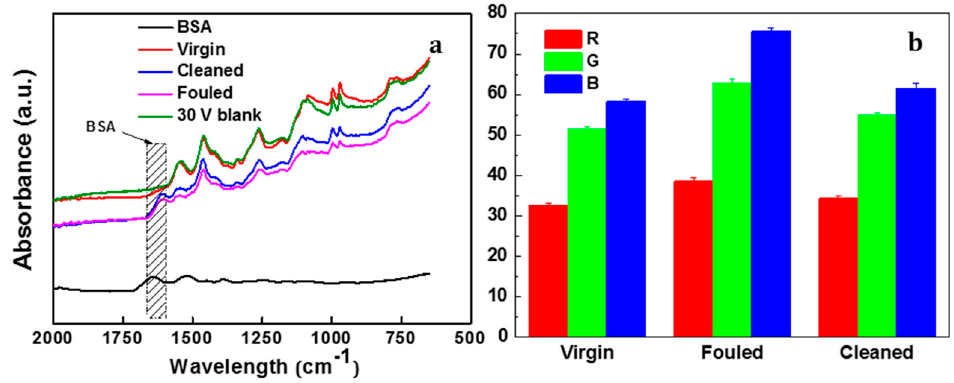
Figure 11. ( a ) FTIR and ( b ) colour change of PANI/EG composite membranes (virgin, BSA fouled and cleaned) (applied potential = 30 V).